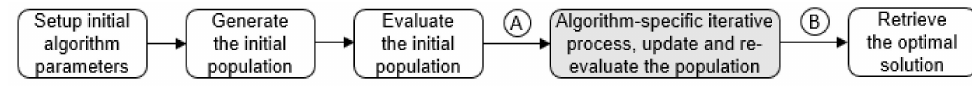
Figure 1. The basic flowchart of a population-based metaheuristic